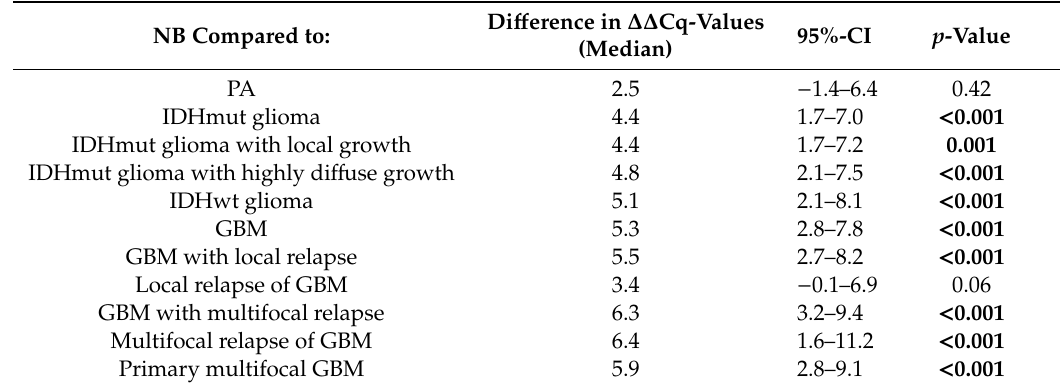
Table 3. Statistical data of the MPS1 mRNA expression